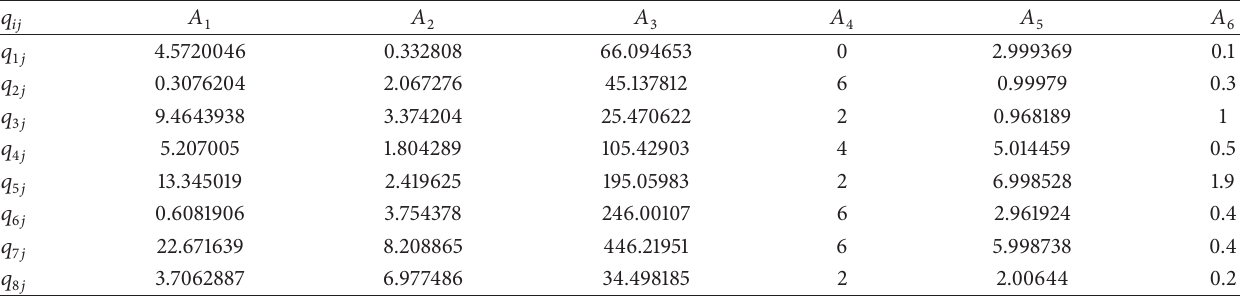
Table 4: Nearness degrees of all index vectors with the fixed index vectors.